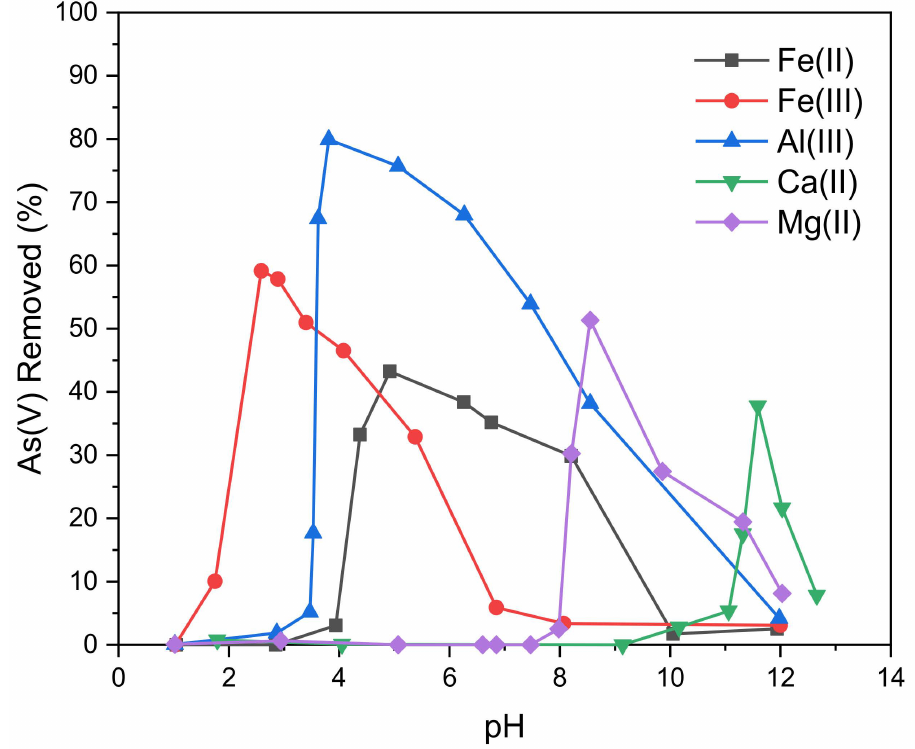
Figure 2. The effect of pH on As(V) removal through precipitation with various metal